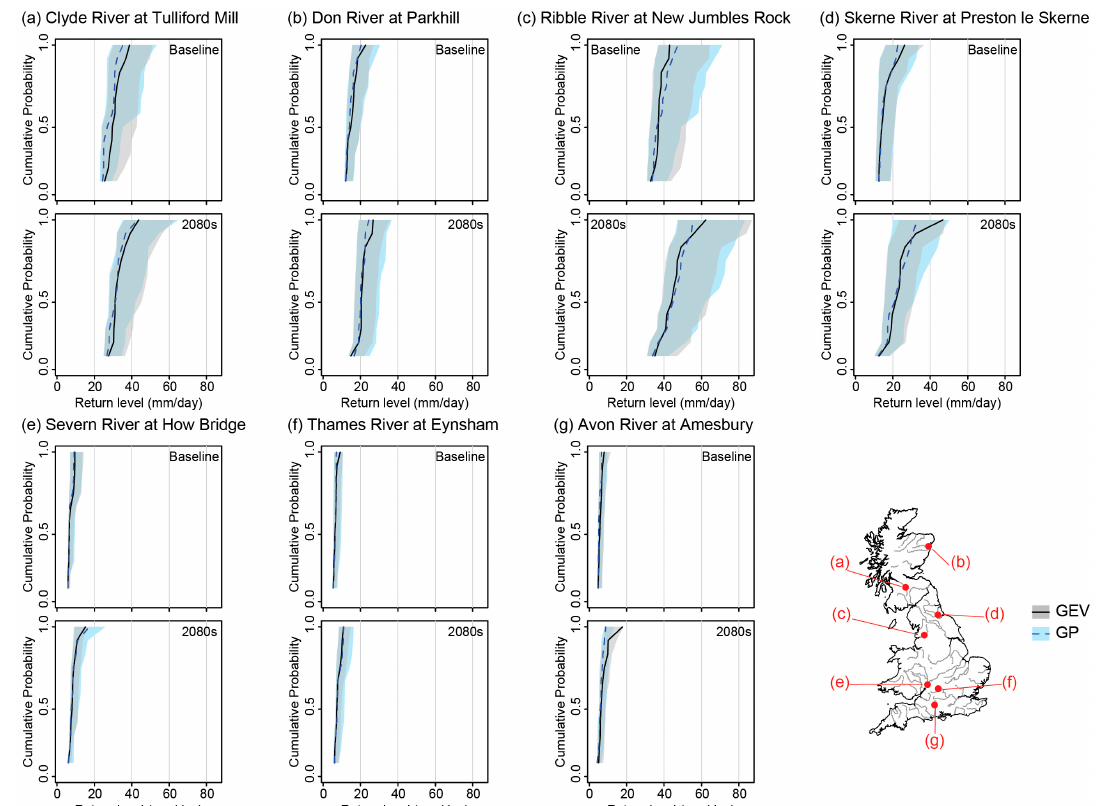
Table 1. For each selected gauging station, on the baseline and the 2080s: combined GEV and GP model uncertainties related to the climate model (CCMU) and the total combined cascaded uncertainty (TCCU).